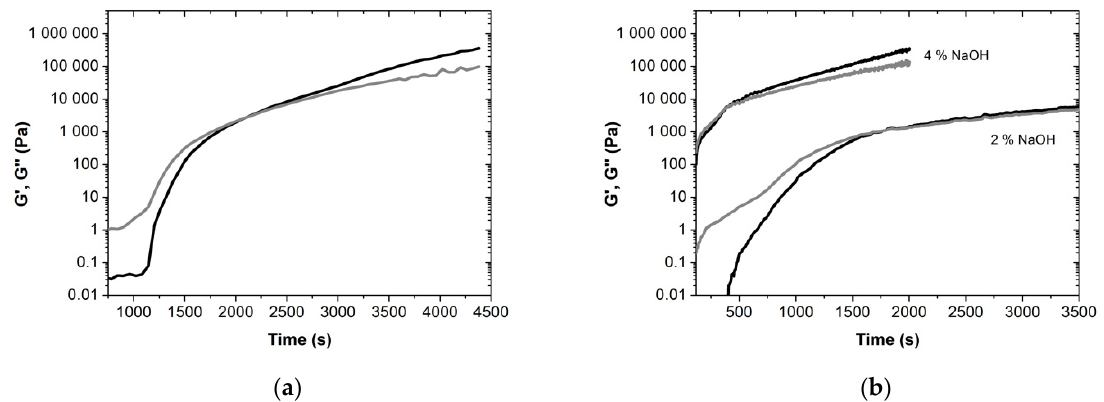
Figure 5. Kinetics of gelation of resole resins ( a ) without lignin; ( b ) with 50 wt% lignin-LA. The G’ (black) and G’’ (gray) are represented as a function of time, at 100 °C.